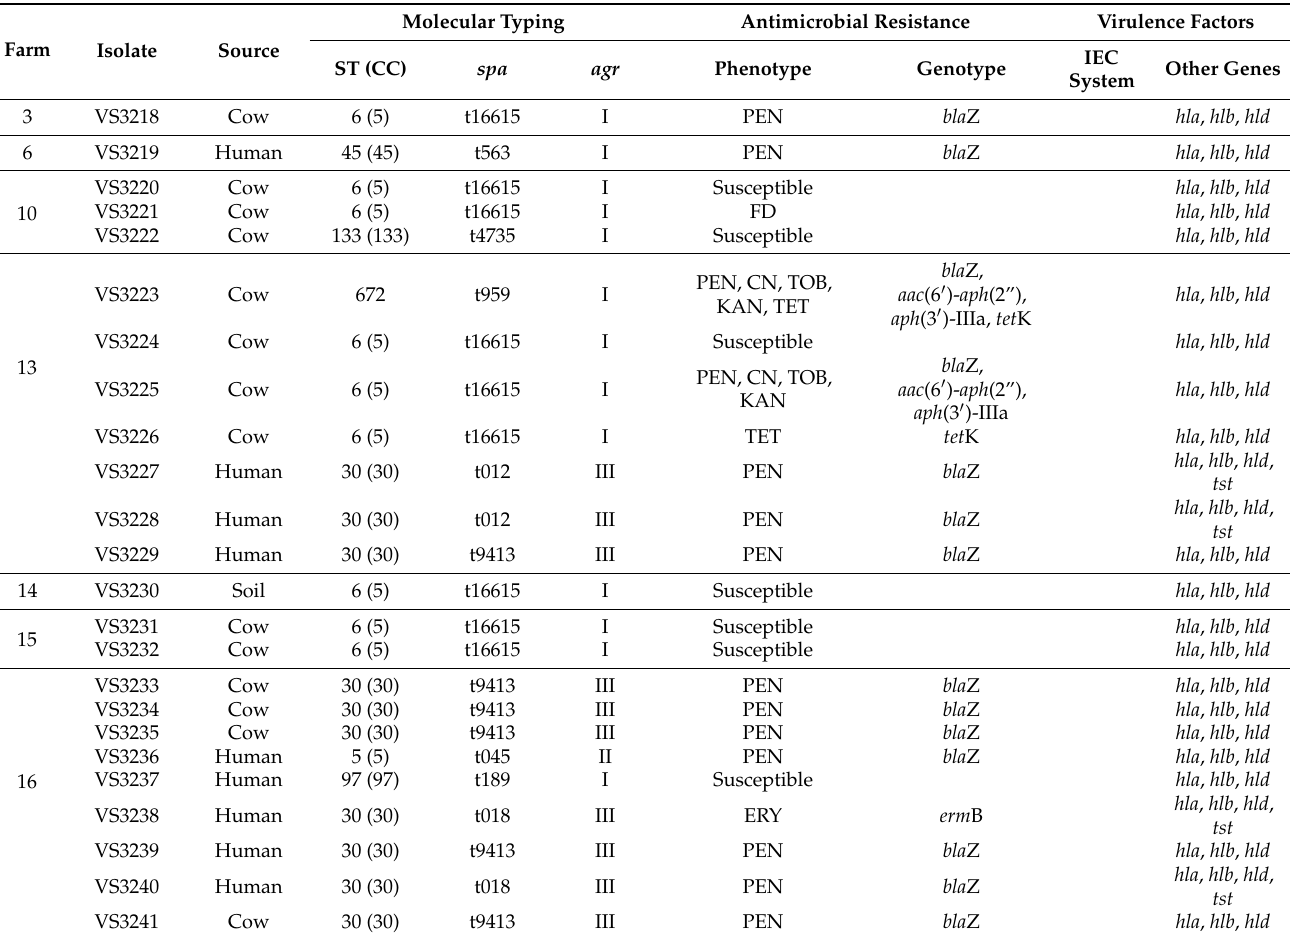
Table 2. S. aureus positive farms, antimicrobial resistance virulence genes, and genetic lineages of the